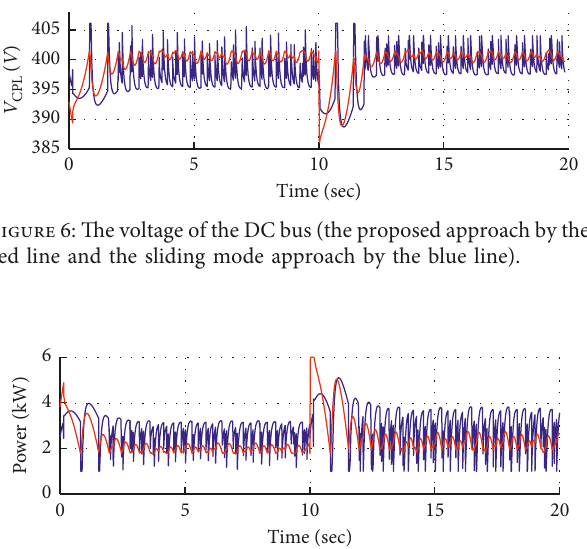
Figure 7: The injected power to the resistive load (the proposed ap- proach by the red line and the sliding mode approach by the blue line). Table 2: Steady-state error of different approaches.